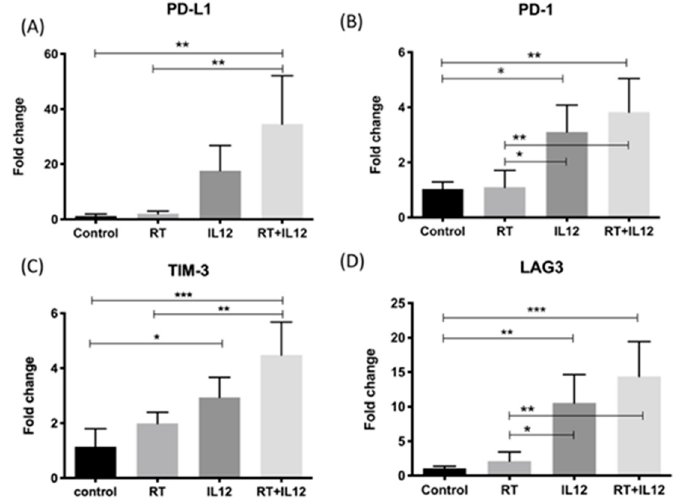
Figure 6. The T cell exhaustion-associated genes were upregulated in IL-12 alone and combined modality groups. The gene expression levels of ( A ) PD-L1, ( B ) PD-1, ( C ) TIM-3, and ( D ) LAG-3 in each tumor at day 7 after treatments was examined by real-time PCR. n = 4 in each group. * p < 0.05, ** p < 0.01, *** p < 0.001.